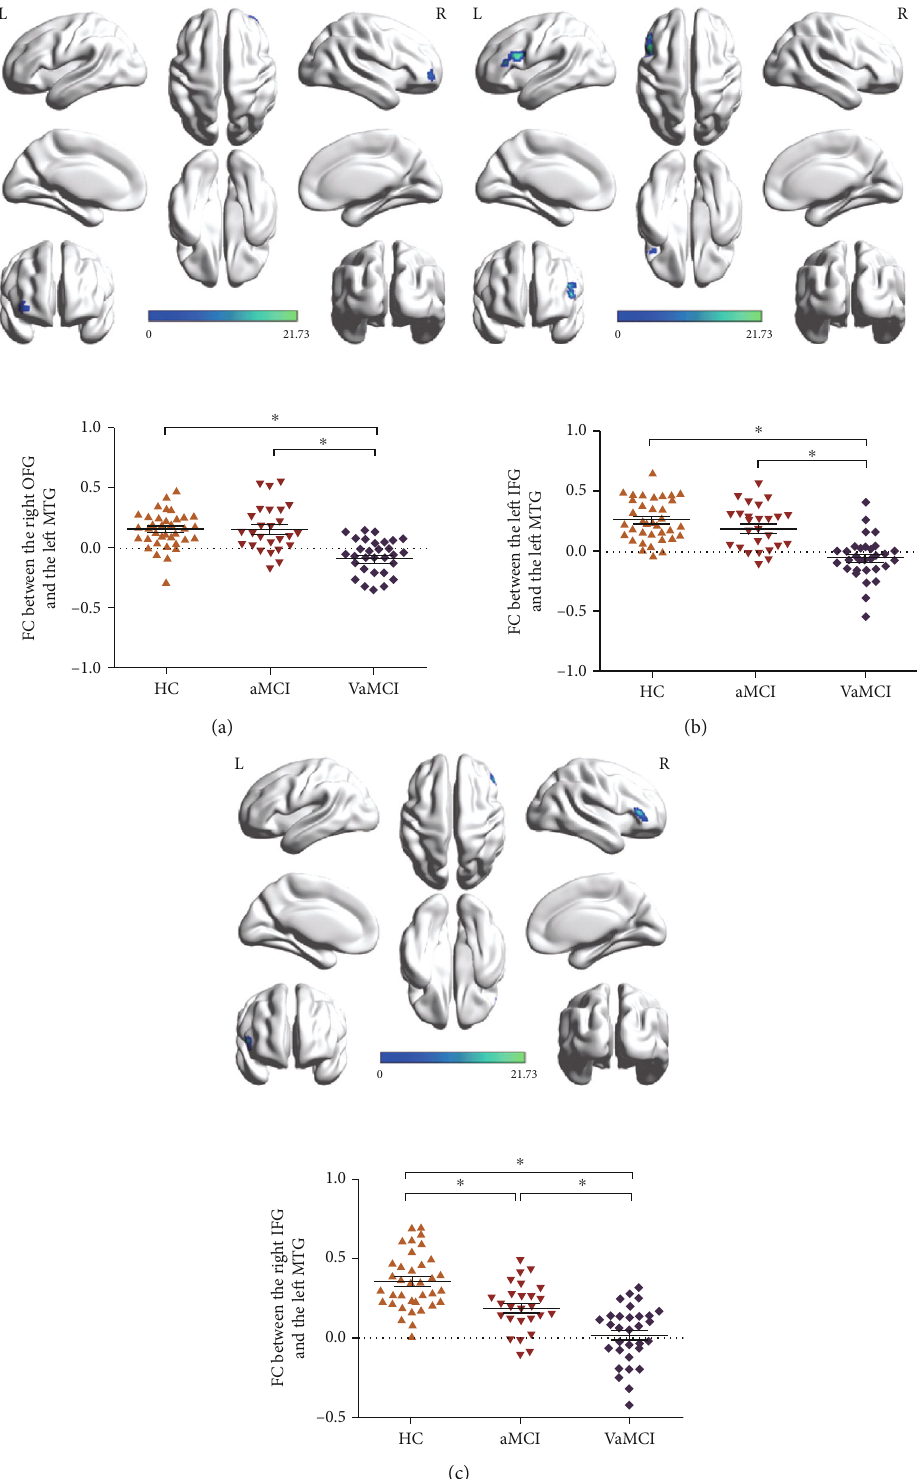
Figure 2: The results of one-way ANCOVA and post hoc analysis indicated signi fi cant decreased FC between the left MTG and the right OFG (a), the left IFG (b), and the right IFG (c) among the three groups. ∗ means p < 0 : 05 in the two-sample t -test using SPSS21. L: left; R: right; FC: functional connectivity; MTG: middle temporal gyrus; OFG: orbital frontal gyrus; IFG: inferior frontal gyrus; VaMCI: vascular mild cognitive impairment; aMCI: amnestic mild cognitive impairment; HC: healthy